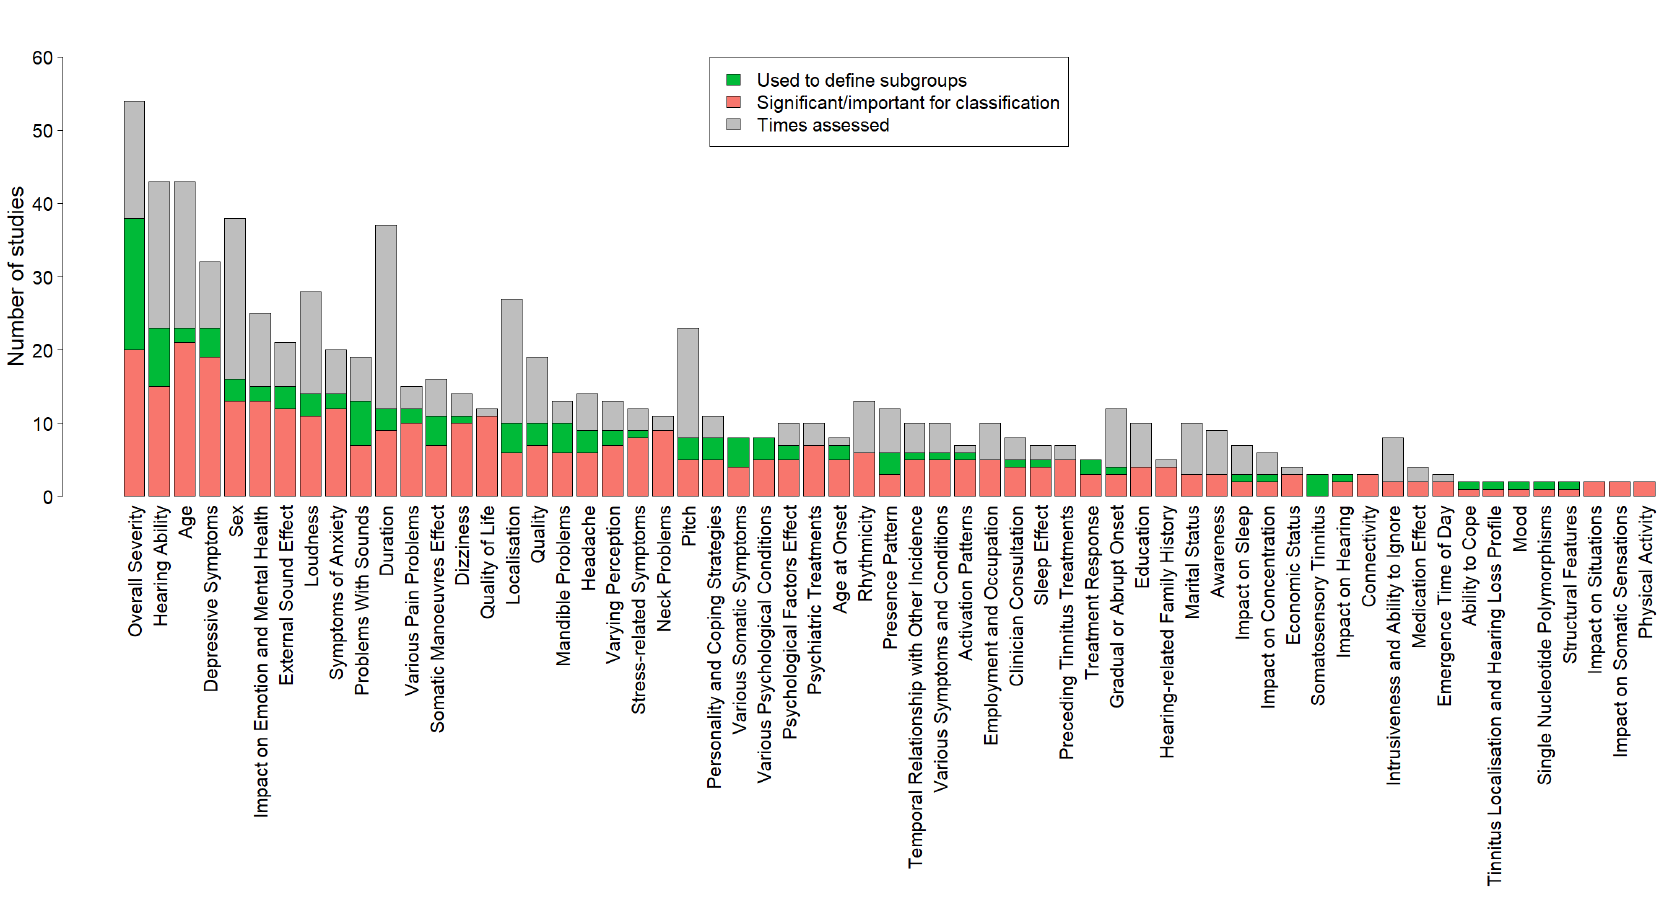
Figure 5. Variables that have been highlighted as important for subphenotyping (used for subgrouping, significantly differing among subgroups, or being important for classification models) in two or more studies. Green shows the number of studies that used each variable to define subgroups. Orange shows the number of studies that found this variable to differ significantly among subgroups or to be important for classification models. Grey shows the number of studies that assessed each variable but did not show it to be important for subphenotyping.